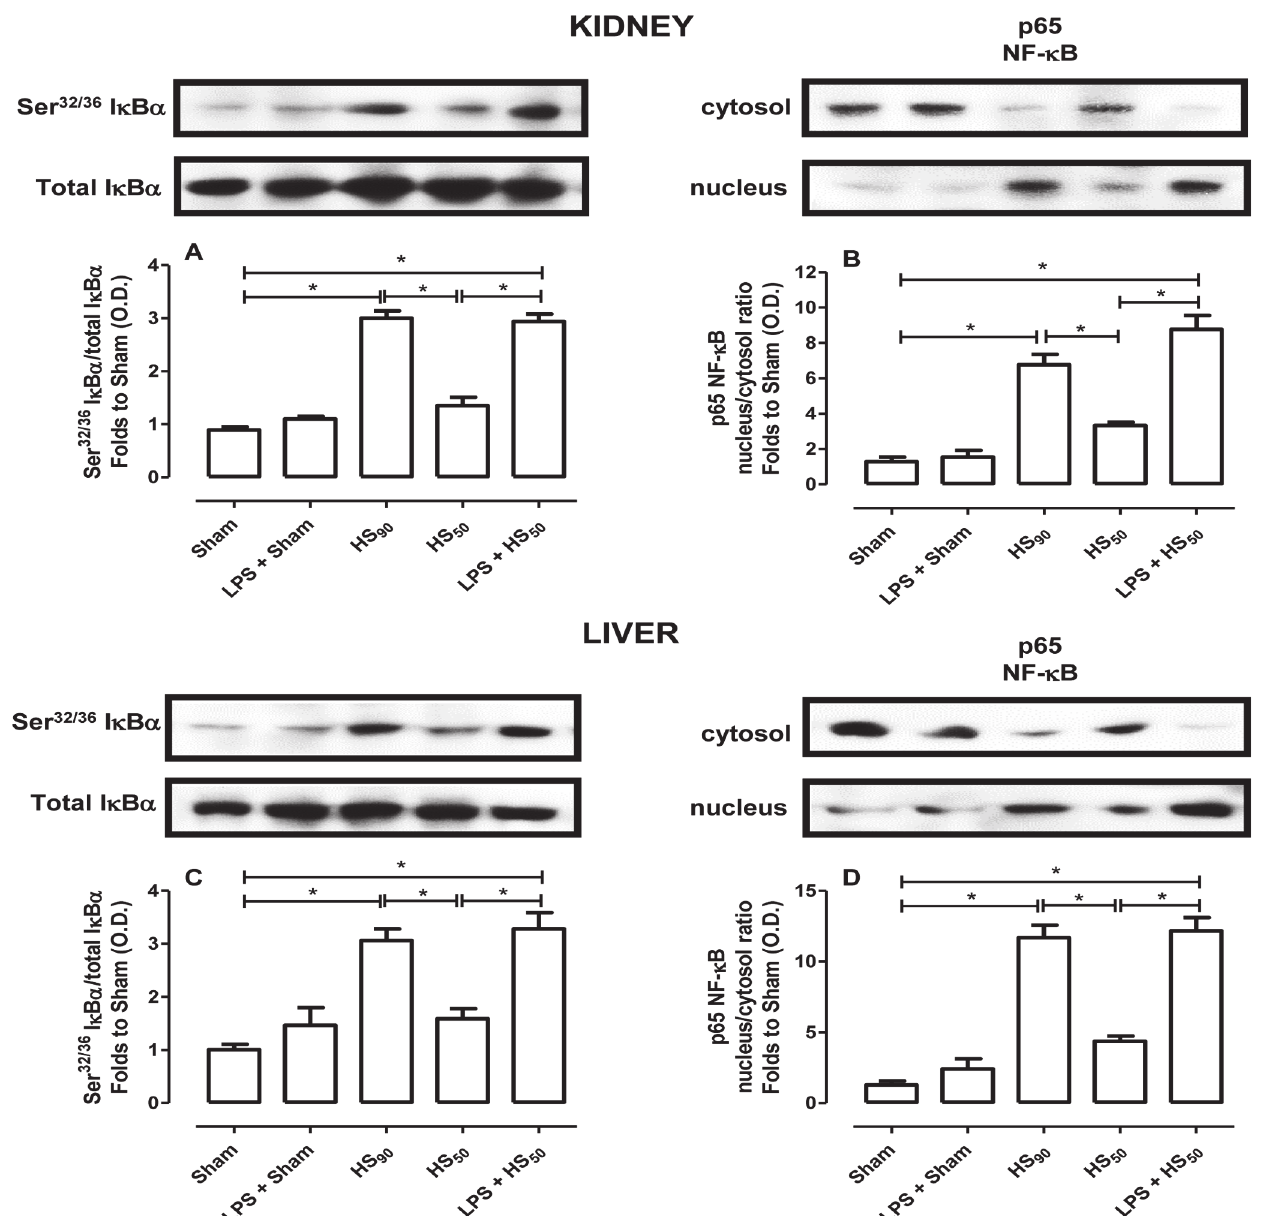
Fig 5. Effect of LPS preconditioning on NF- ĸ B activation. Rats were injected vehicle (PBS) or LPS (1 mg/kg) i.p. 24 h prior to HS 90 or HS 50 . The phosphorylation of I ĸ B α on Ser 32/36 (A and C) and the nuclear translocation of the p65 NF- ĸ B subunit (B and D) on the kidney (A and B) and liver (C and D) were determined by western blotting. Protein expression was measured as relative optical density (O.D.), corrected for the corresponding β -actin contents and normalized using the related Sham band. Data are expressed as mean ± SEM of n observations. Statistical analysis was performed using one-way ANOVA followed by Bonferroni ’ s post hoc test. * p < 0.05 among the